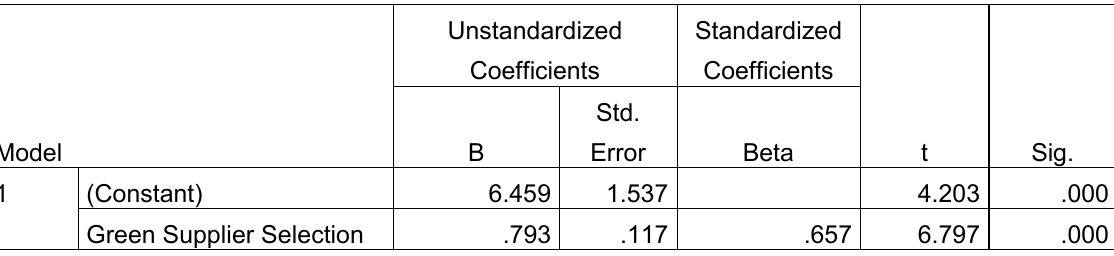
Table 4. Regression Analysis